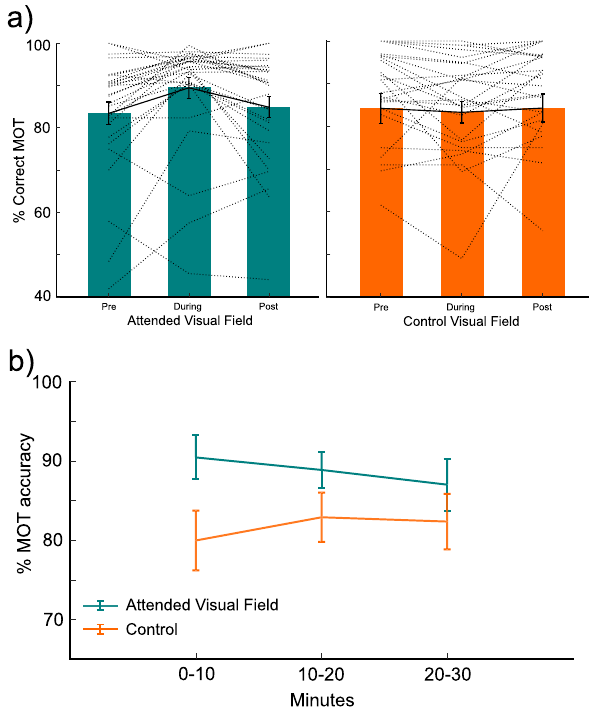
Figure 3. Percentage correct multiple object tracking accuracy pre-, during, and post-manipulation. ( a ) MOT percent accuracy for pre-, during-, and post-manipulation for the attended visual field and control. Dotted lines represent individual subject data. ( b ) Percentage correct multiple object tracking accuracy for each 10-min bin during manipulation period. Attended visual field in teal (unilateral tracking), Control visual field in orange (bilateral